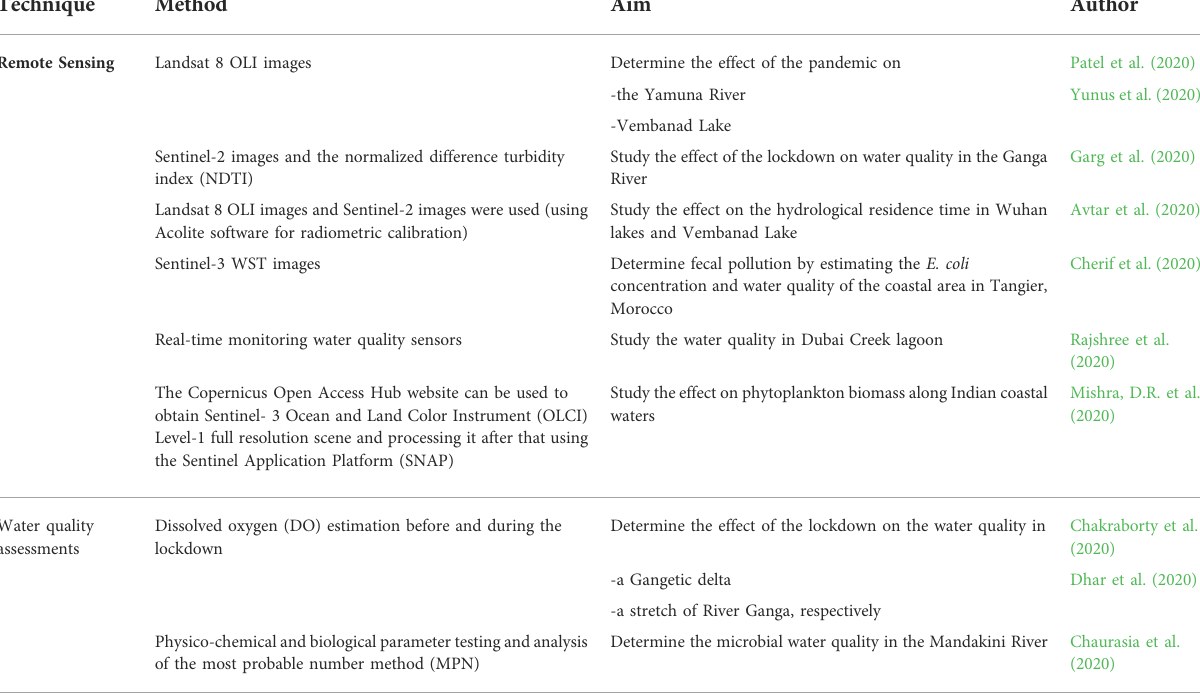
TABLE 3 Different methods to detect the effects of COVID-19 lockdown on water quality.